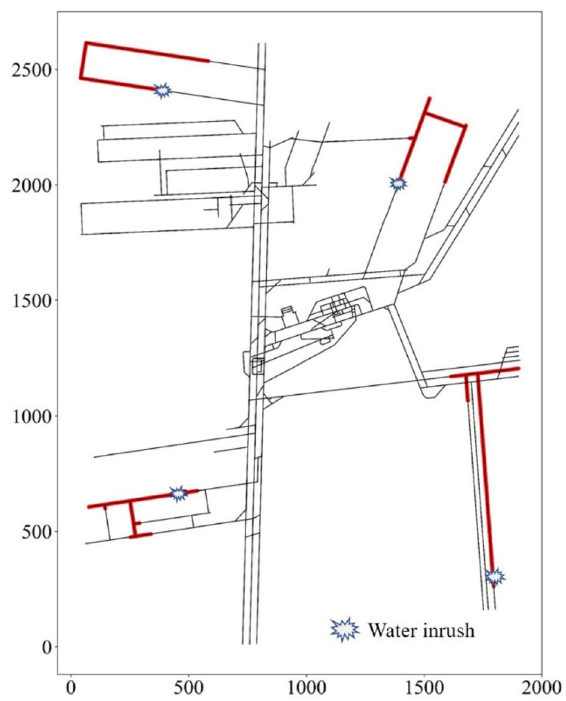
Figure 8. The spreading scopes of water inrush at four